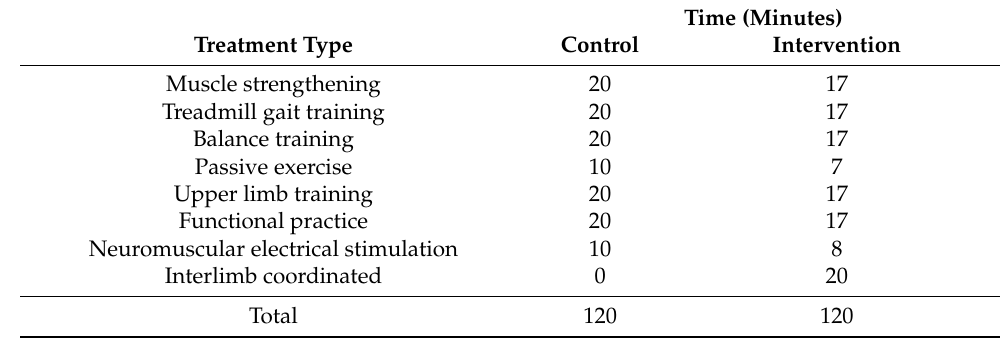
Table 3. Time allocation for each treatment in the control and intervention